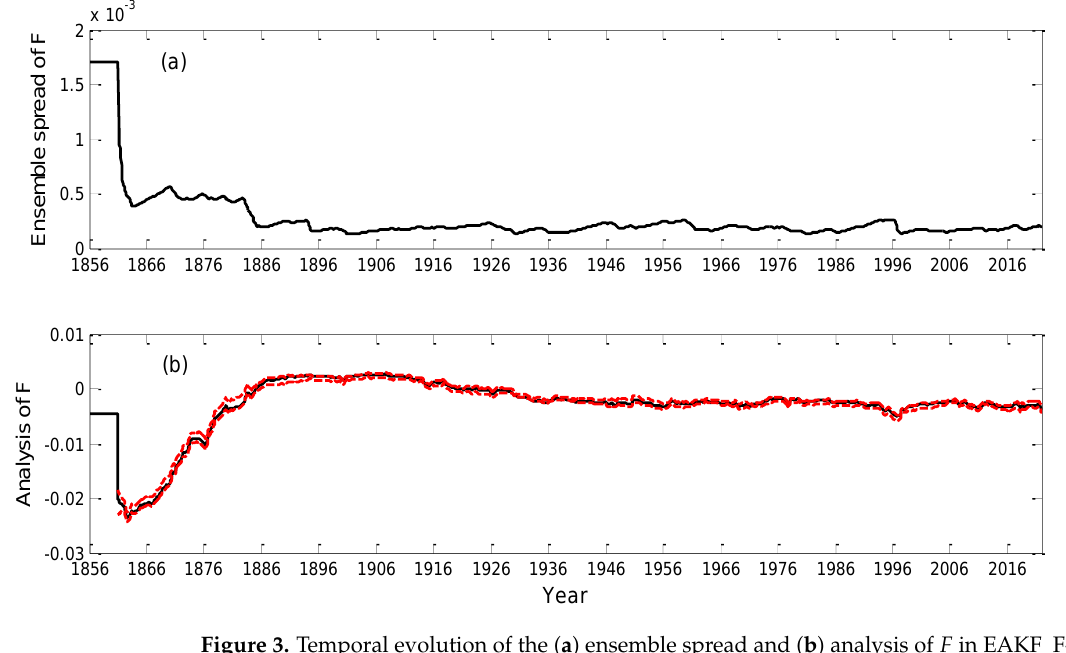
Figure 3. Temporal evolution of the ( a ) ensemble spread and ( b ) analysis of 𝐹 in EAKF_F-Assim. The black line in ( b ) represents the average of the ensemble members, and the two red dashed lines are the maximum and minimum members.